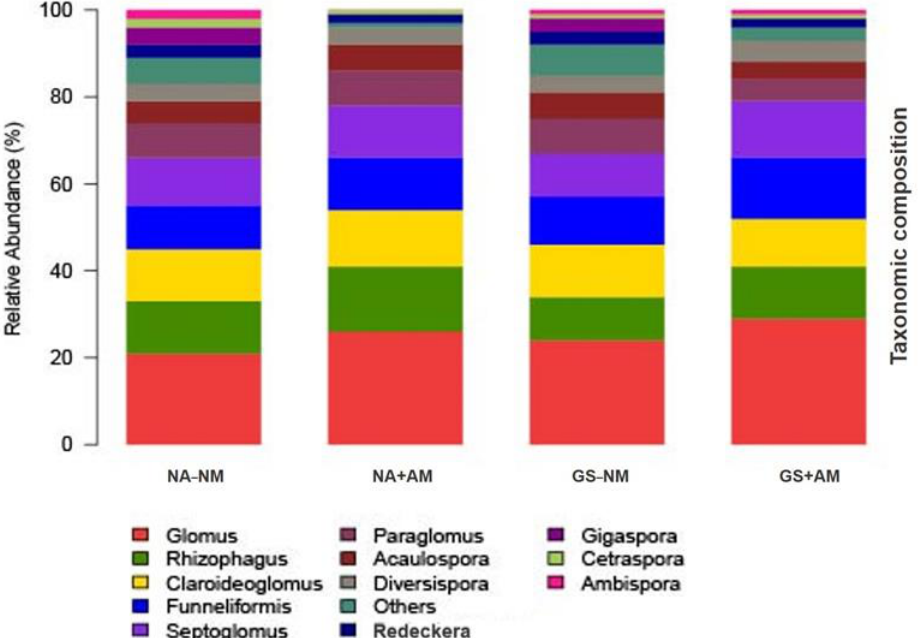
Figure 3. The relative abundance of major identified taxonomic genera of AMF across all treatments. The treatments NA-NM, NA+AM, GS-NM and GS+AM represent the applied soil amendments. Non-amendment and non-mycorrhizal inoculation, non-amended mycorrhizal Inoculation, garlic stalk amended with non-mycorrhizal inoculum and Garlic stalk amended with mycorrhizal inoculum, respectively.